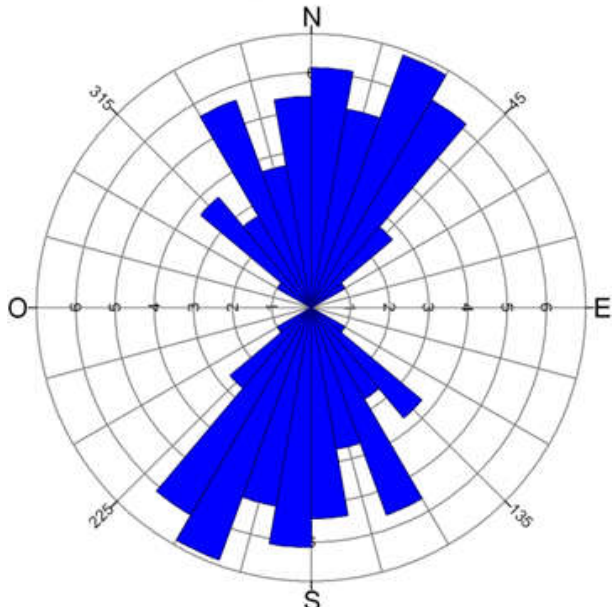
Figure 13. Directional rosette of the lineaments.